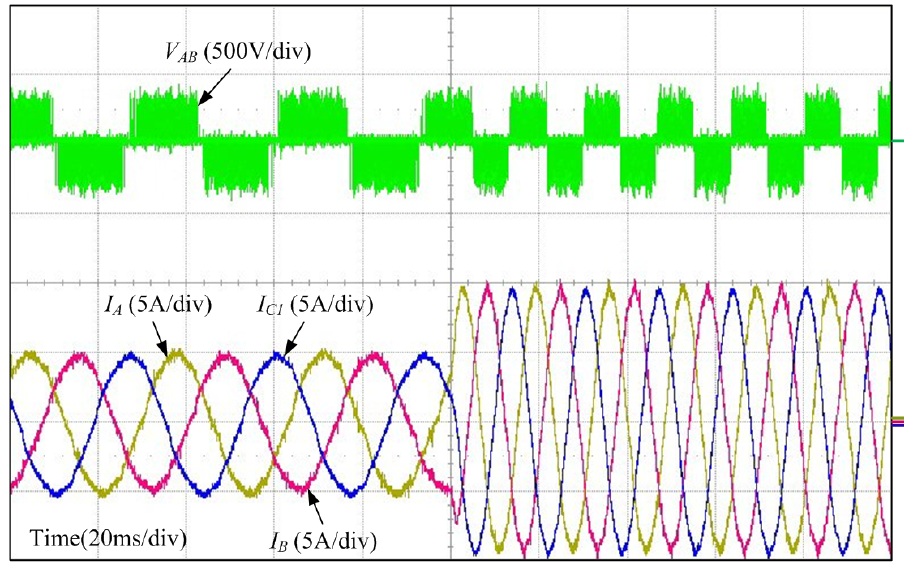
Figure 15. Experimental waveforms of the output line-to-line voltage and the output currents for the three-phase load.